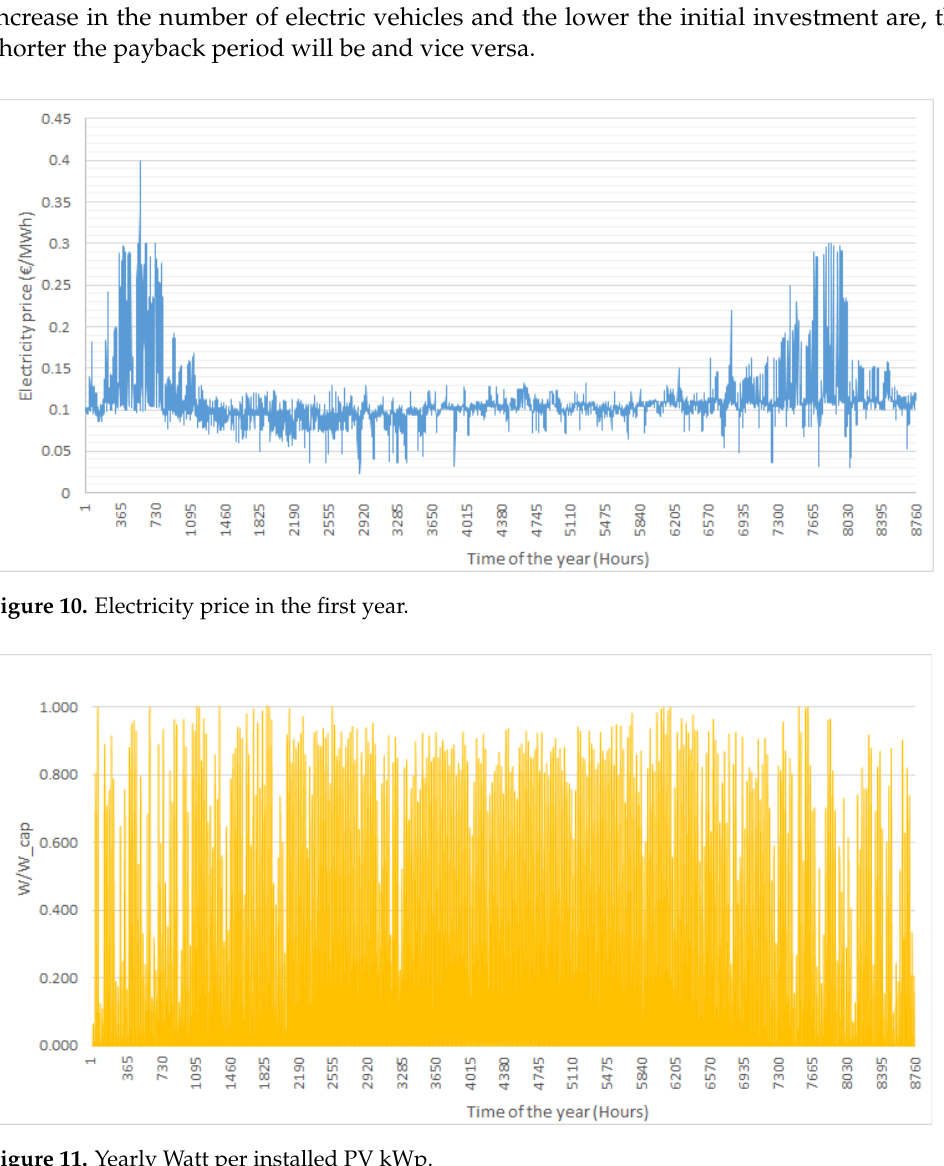
Figure 9. Microgrid layout.